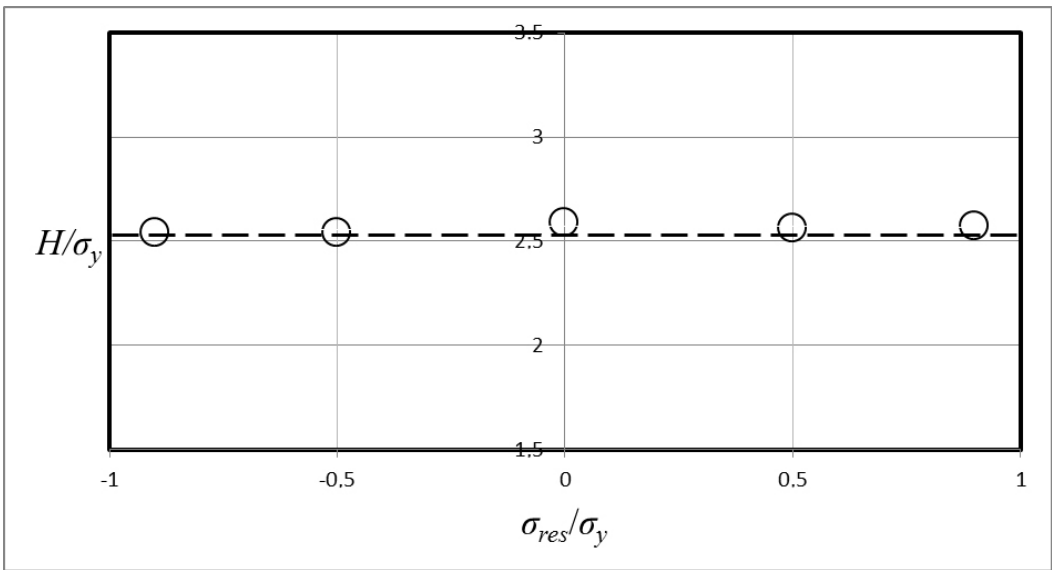
Figure 7. Normalized hardness, H / σ y , as a function of the nondimensionalized equi-biaxial residual stress field, σ re s / σ y , at cone indentation with β = 22 ◦ . The results are pertinent to indentation of an elastic-ideally plastic material with ln Λ = 5 where Λ is defined according to Equation (1). (- - -), Equation (16). (o), numerical results for different values on σ re s / σ y . The results are taken from Rydin and Larsson [9].